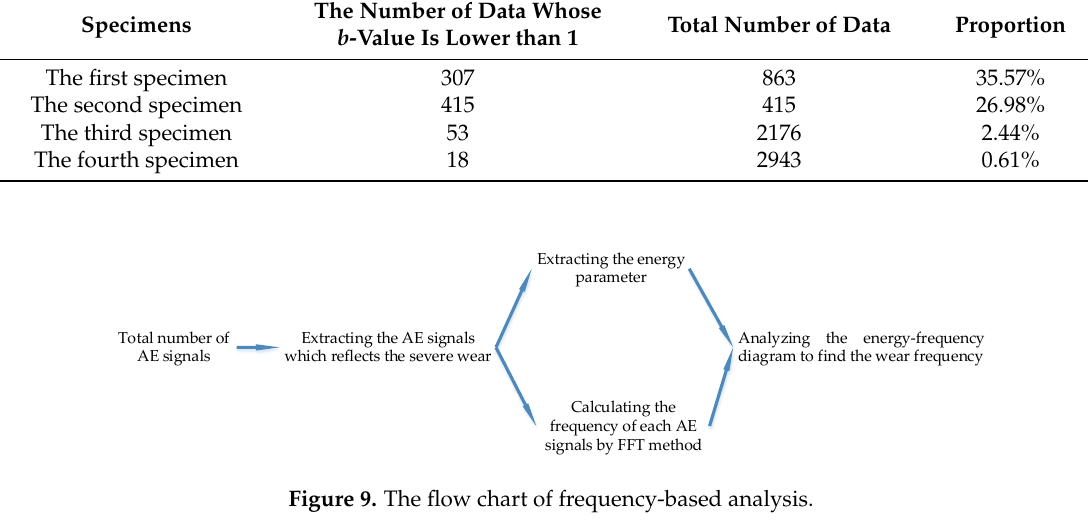
Table 5. The statistic of b -value distribution.